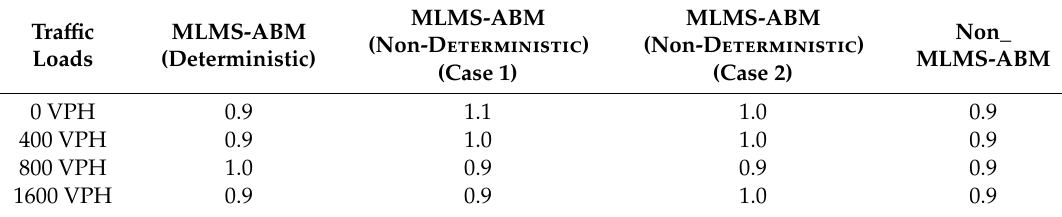
Table 3. Comparing flow rates for the hypothetical road network and the I-25 road network.